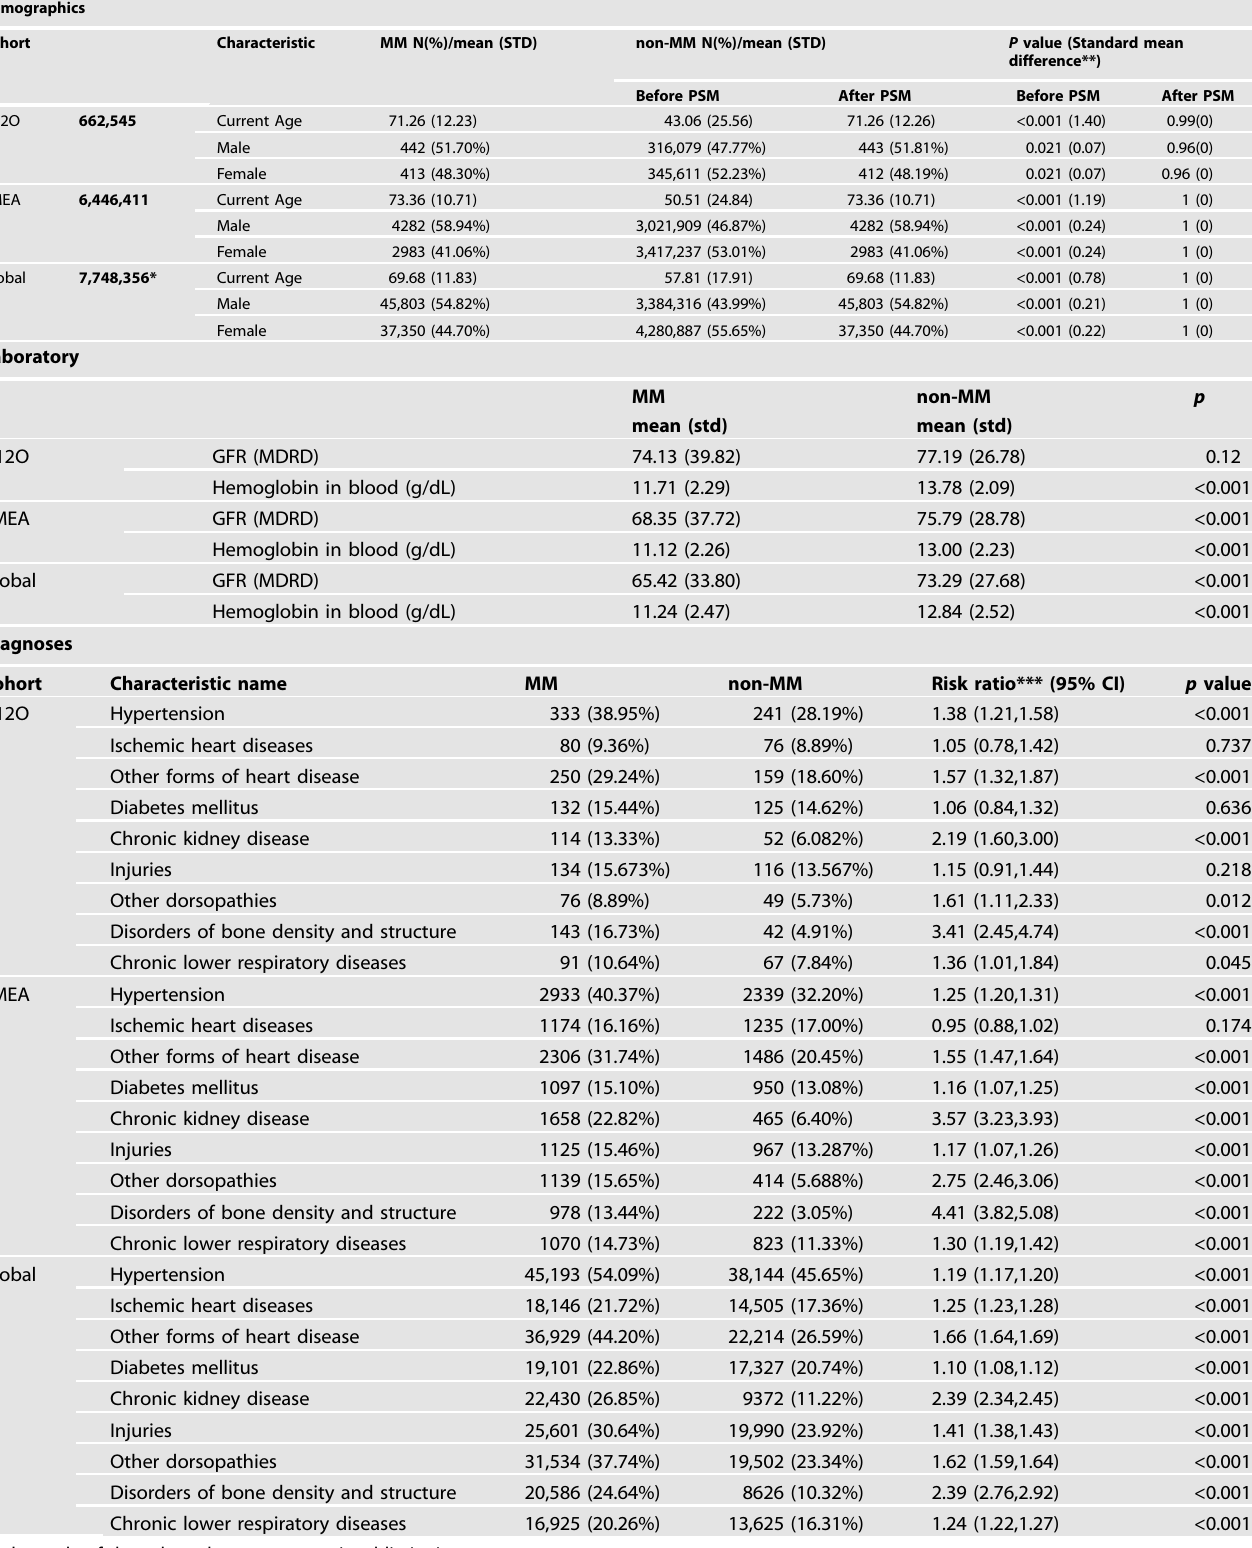
Table 1. Characteristics of Multiple Myeloma (MM) cohorts in H12O, EMEA and Global data networks, compared with non-MM cohorts before and after propensity score matching (PSM) on age and gender.